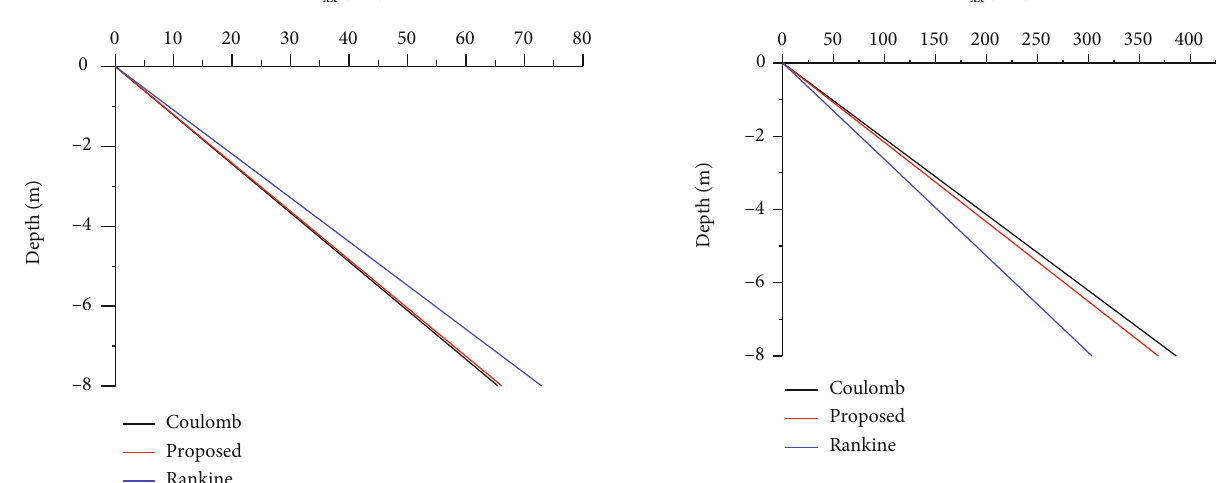
Figure 7: Comparison of horizontal components of the passive earth pressure. Figure 6: Comparison of horizontal components of the active earth